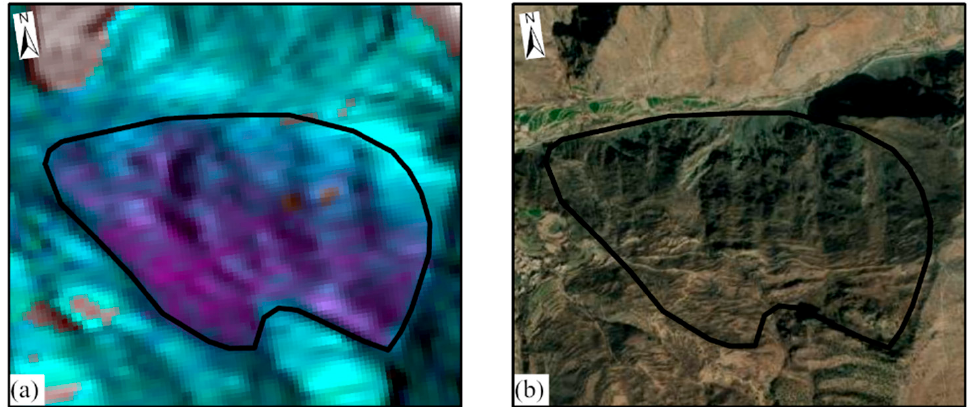
Figure 12. The landslide highlighted by rectangle 2 in Figure 11 in ( a ) InSAR imagery and ( b ) optical remote sensing imagery. Table 4. Quantitative assessment, complexity of different models in the test area.